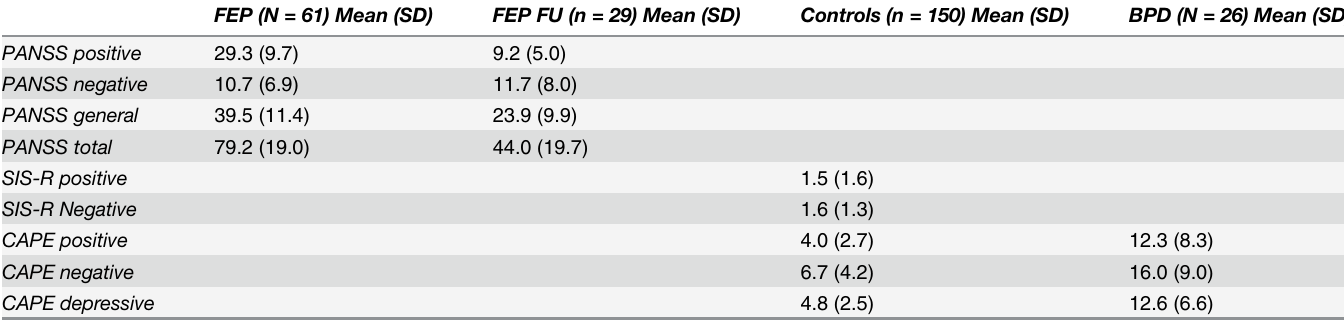
Table 2. Clinical